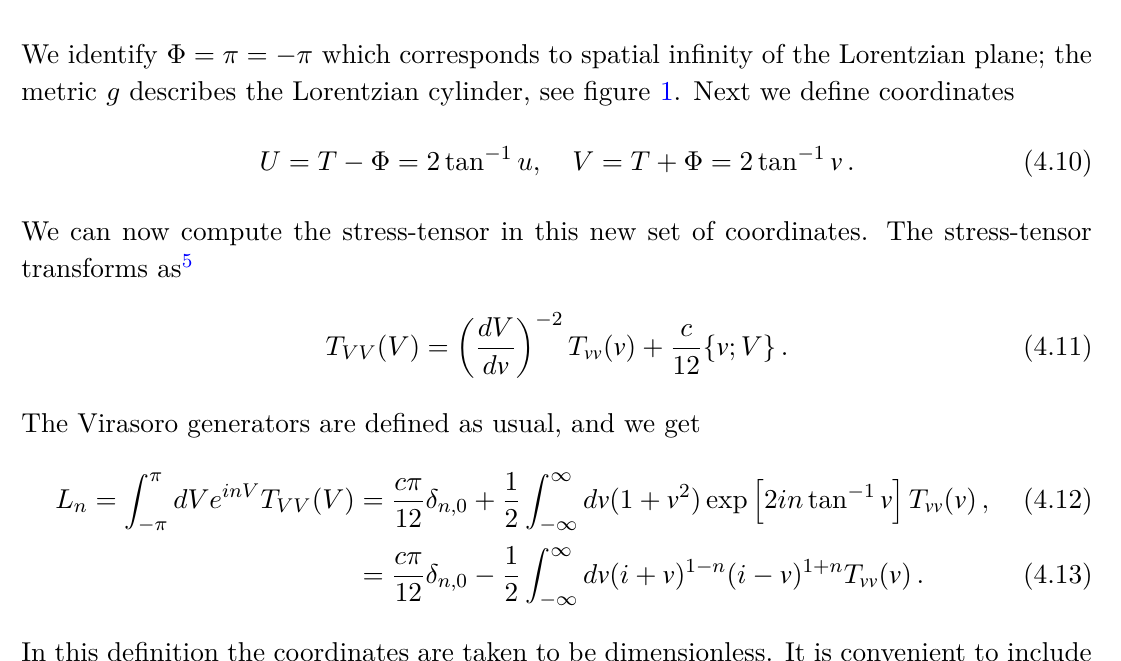
Figure 1 . Embedding of the Minkowski plane on the Lorentzian